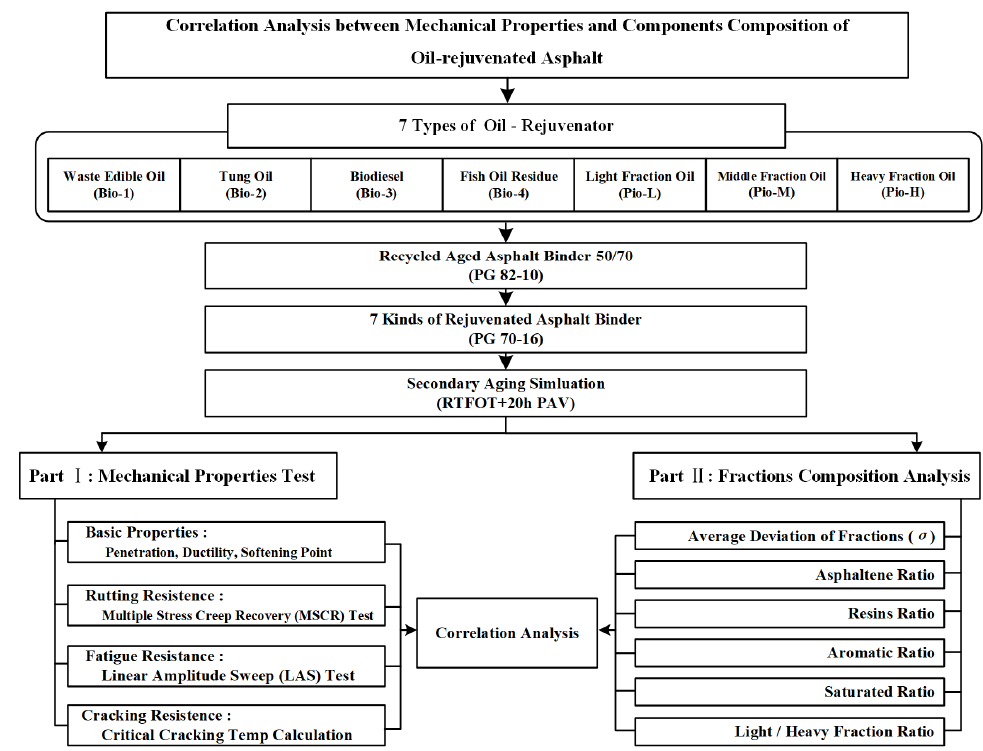
Figure 1. Schematic of the experimental test